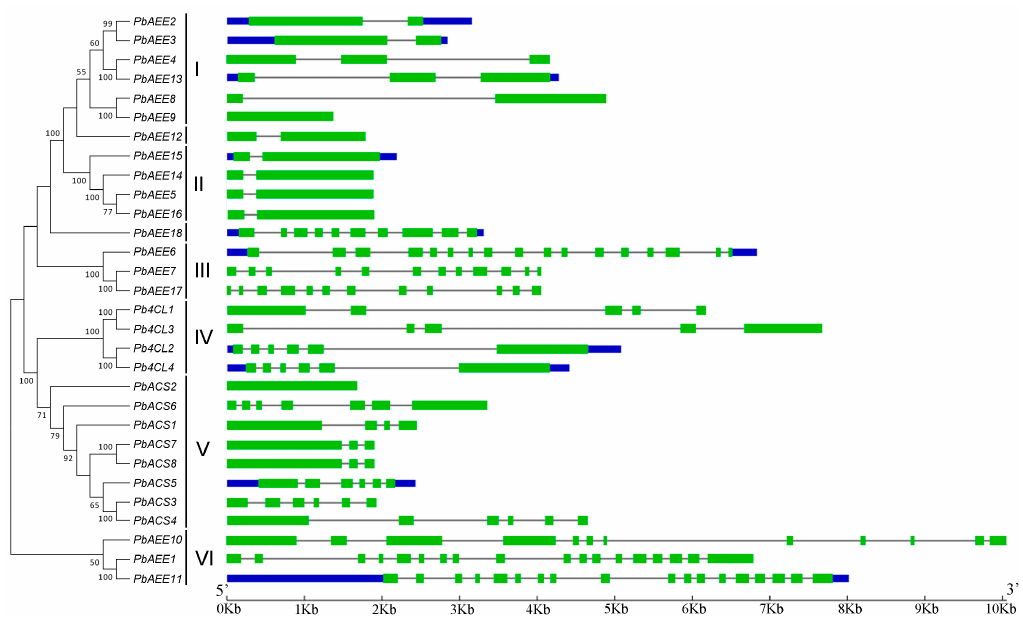
Figure 2. Phylogenetic and exon–intron structure analyses of the 30 predicted pear 4CL ‐ related genes. The neighbor joining (NJ) tree is shown on the left. The phylogenetic tree was constructed with MEGA 6.0 [52] using the full ‐ length amino acid sequences of the 30 pear 4CL ‐ related proteins. Bootstrap values are represented by black numbers. The gene structures are shown on the right. Exons, introns and untranslated regions (UTRs) are indicated by green boxes, gray lines, and blue boxes, respectively. The length of each 4CL ‐ related gene can be estimated based on the scale at the bottom.